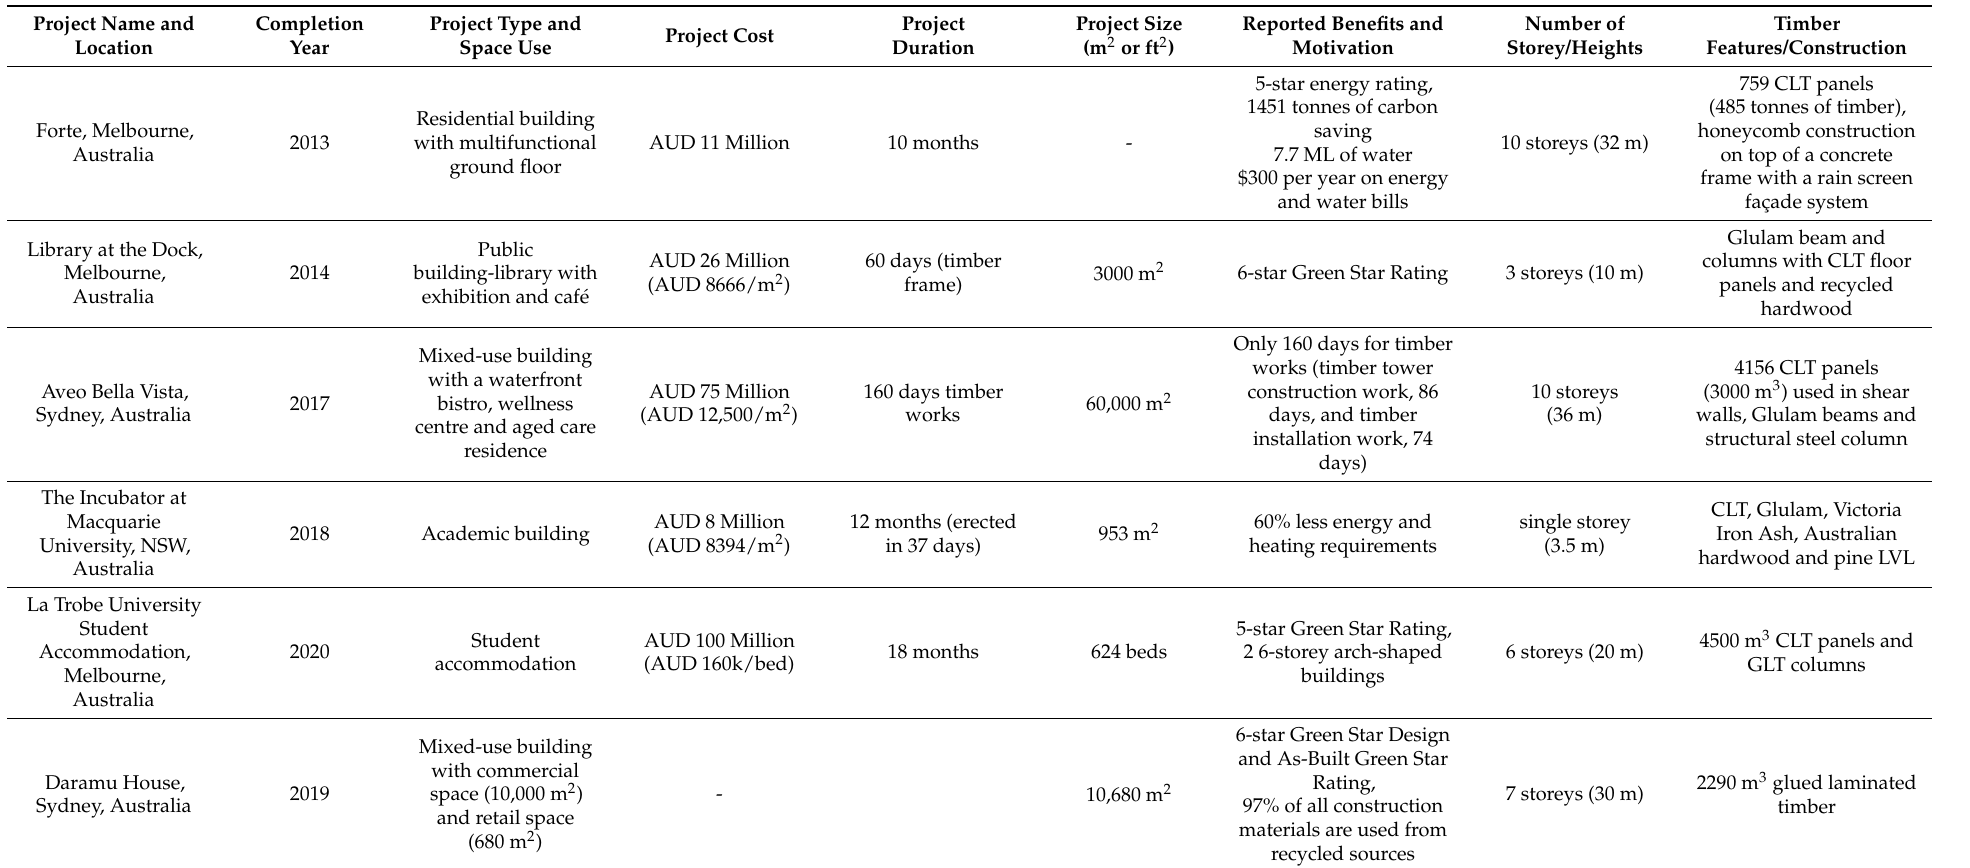
Table A1. Selected mass timber projects around the